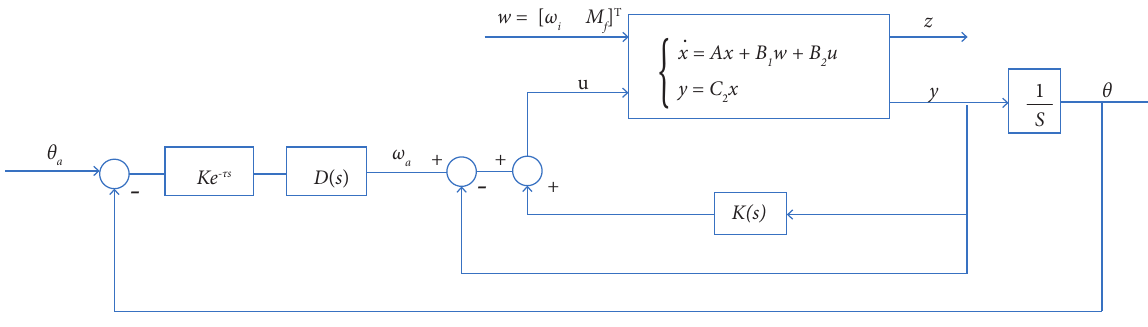
Figure 2. Stable tracking system